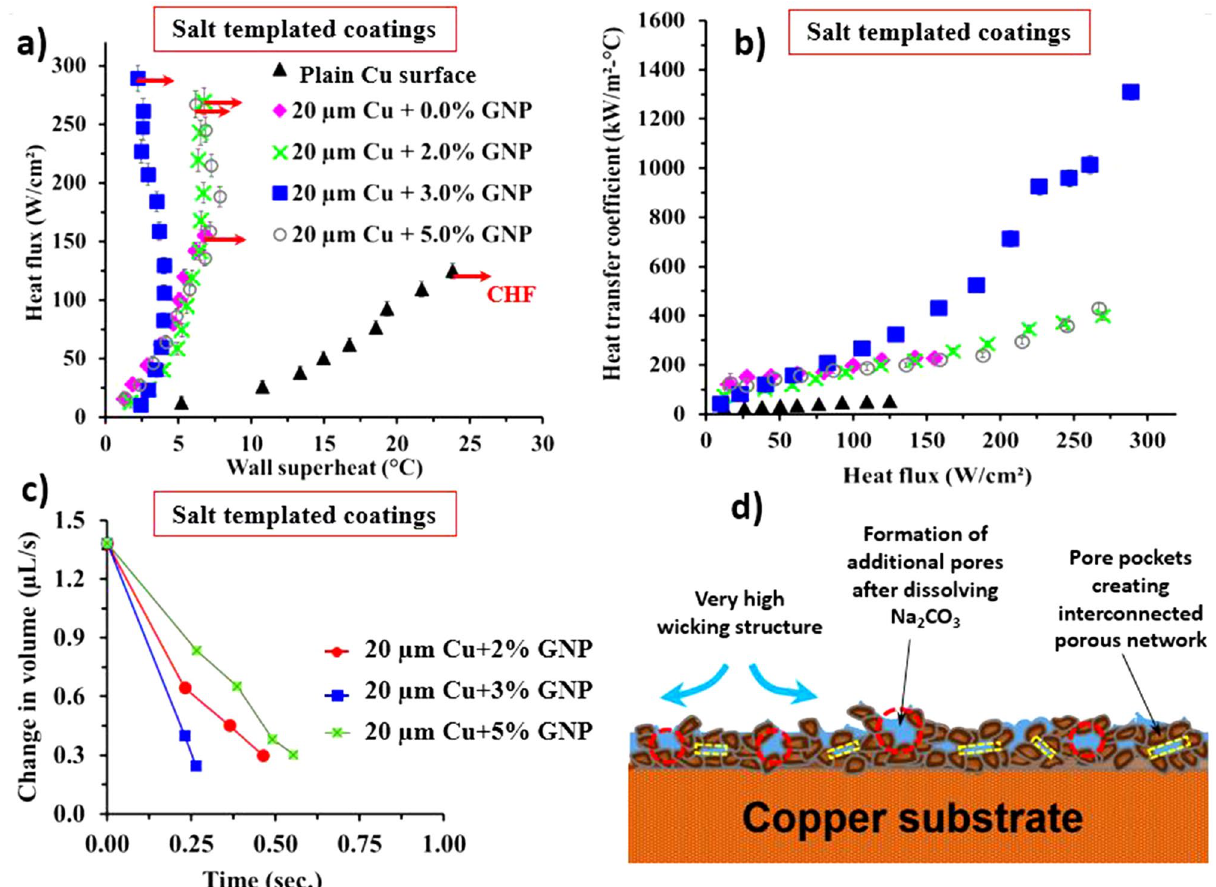
Figure 4. Comparison of effect of salt templating during sintering on pool boiling performance of 2%, 3%, and 5% GNP draped 20 µm Cu coatings showing ( a ) heat flux versus wall superheat depicting pool boiling regimes, ( b ) heat transfer coefficient versus heat flux summarizing heat transfer performance, ( c ) comparison of change in water droplet volumes, ( d ) schematic indicating the factors responsible for enhancement in pool boiling